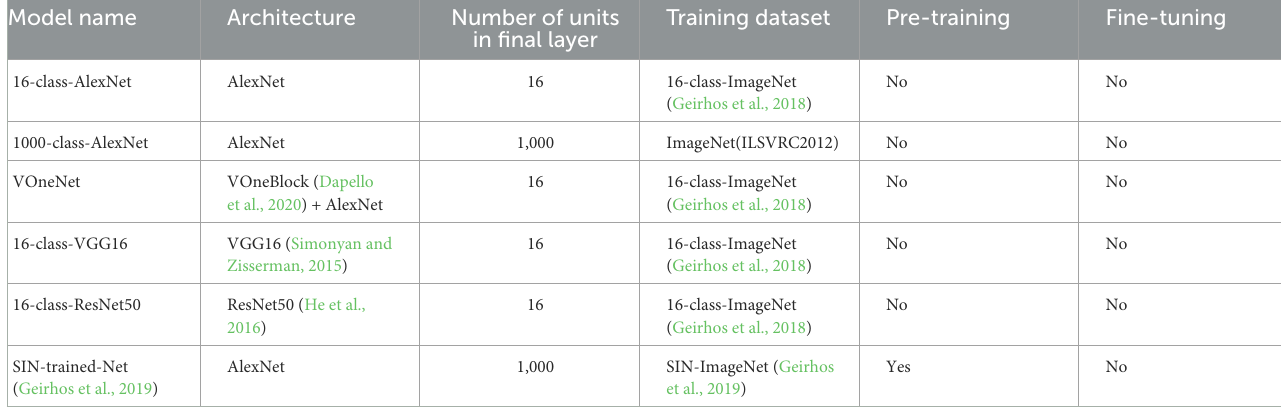
TABLE 1 CNN models used in this